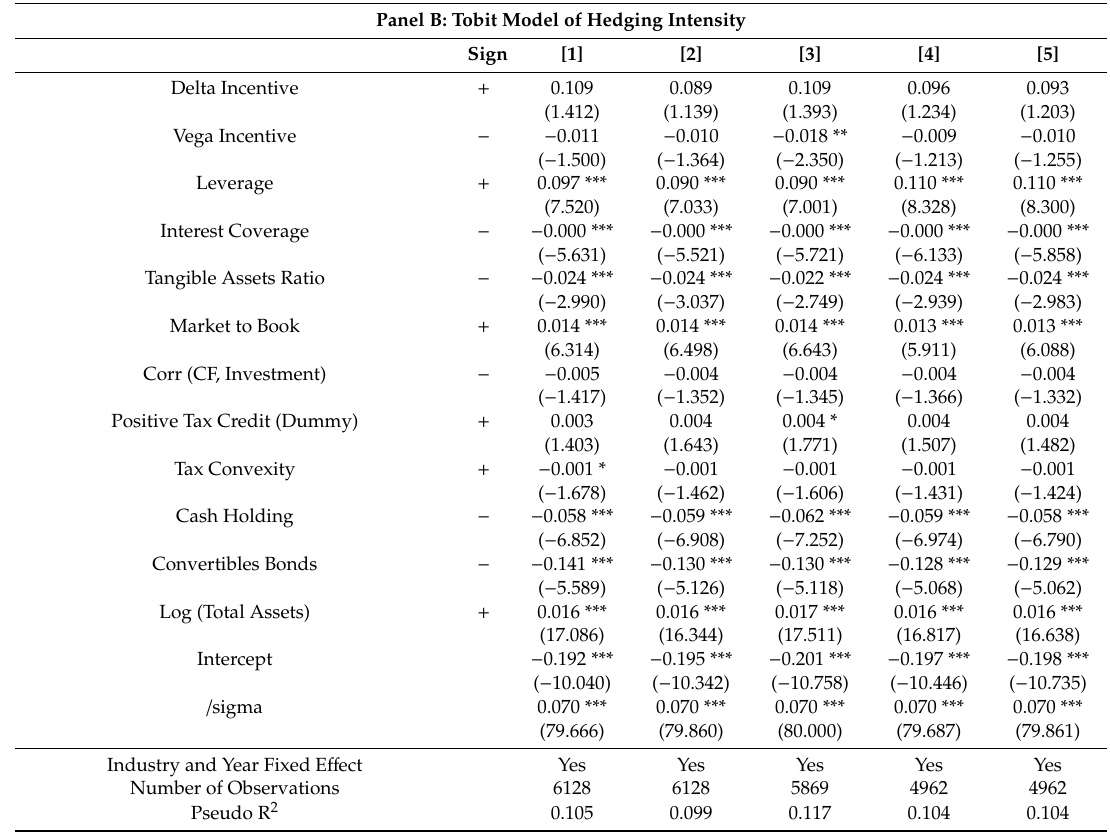
Table 3. Cont . Panel B: Tobit Model of Hedging